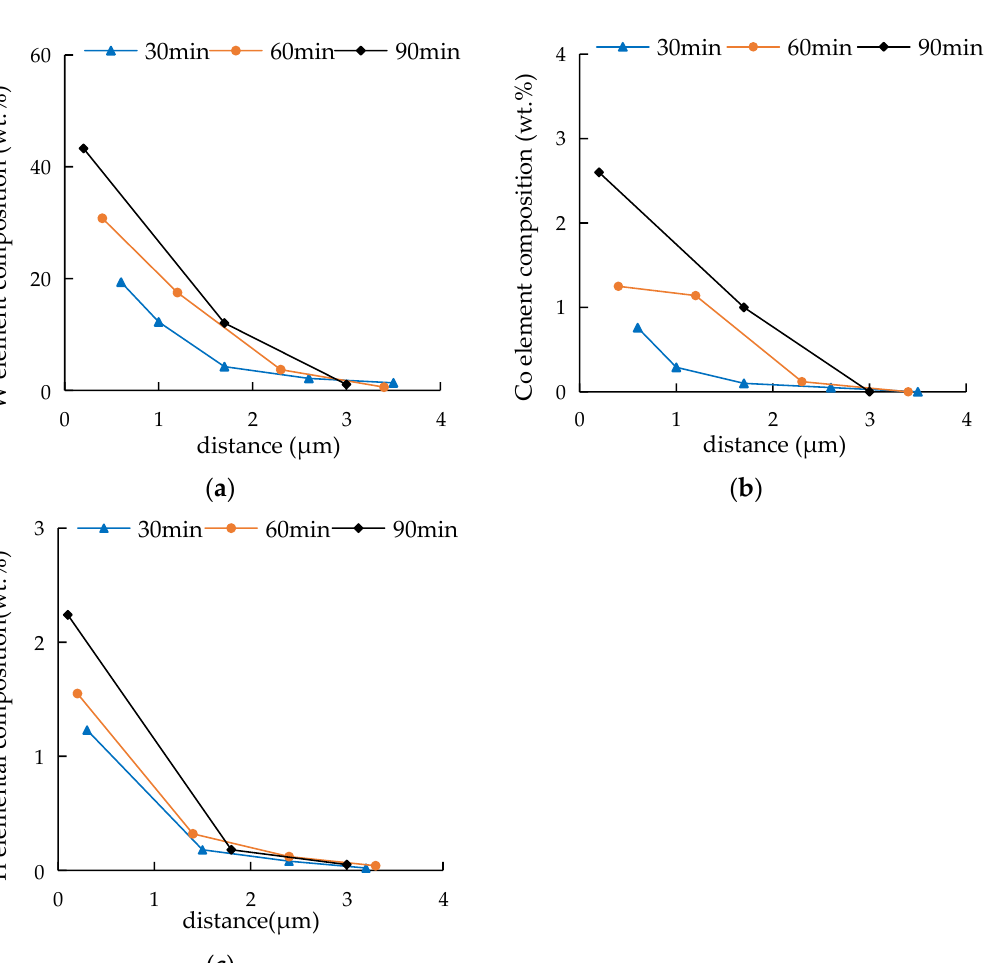
Figure 9. Oxidation analysis of the cemented carbide at 800 °C.